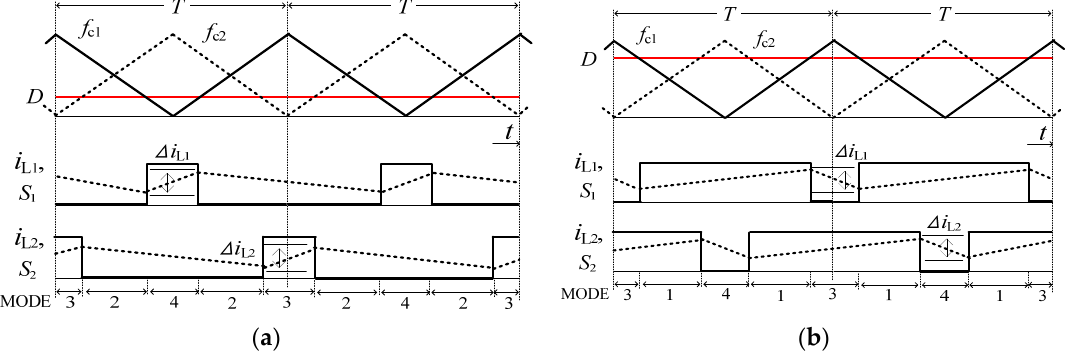
Figure 3. Carriers and switching modes of interleaving method. ( a ) 𝐷 ≤ 0.5 ; ( b ) 𝐷 > 0.5 .